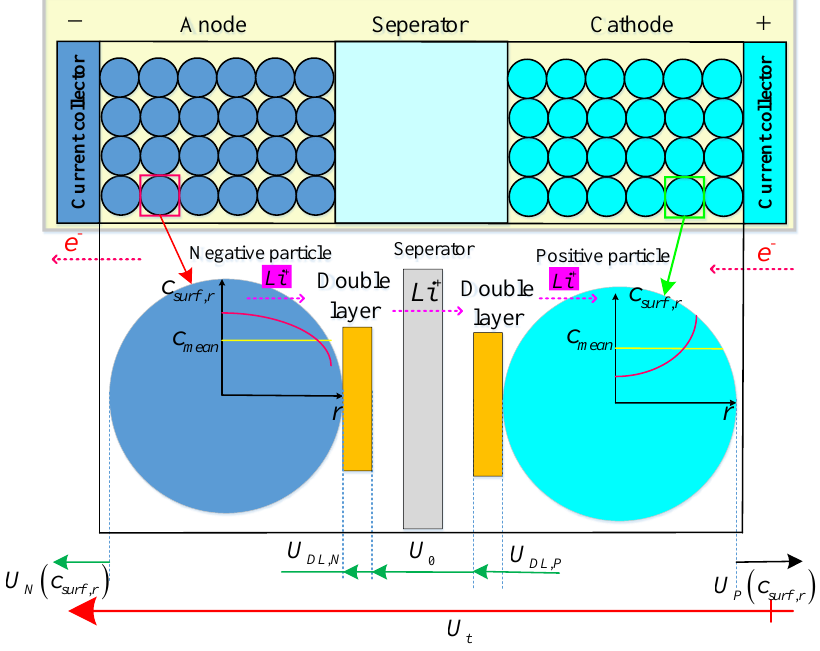
Figure 1. Schematic of the single-particle model (SPM) (modified from Reference [23]).